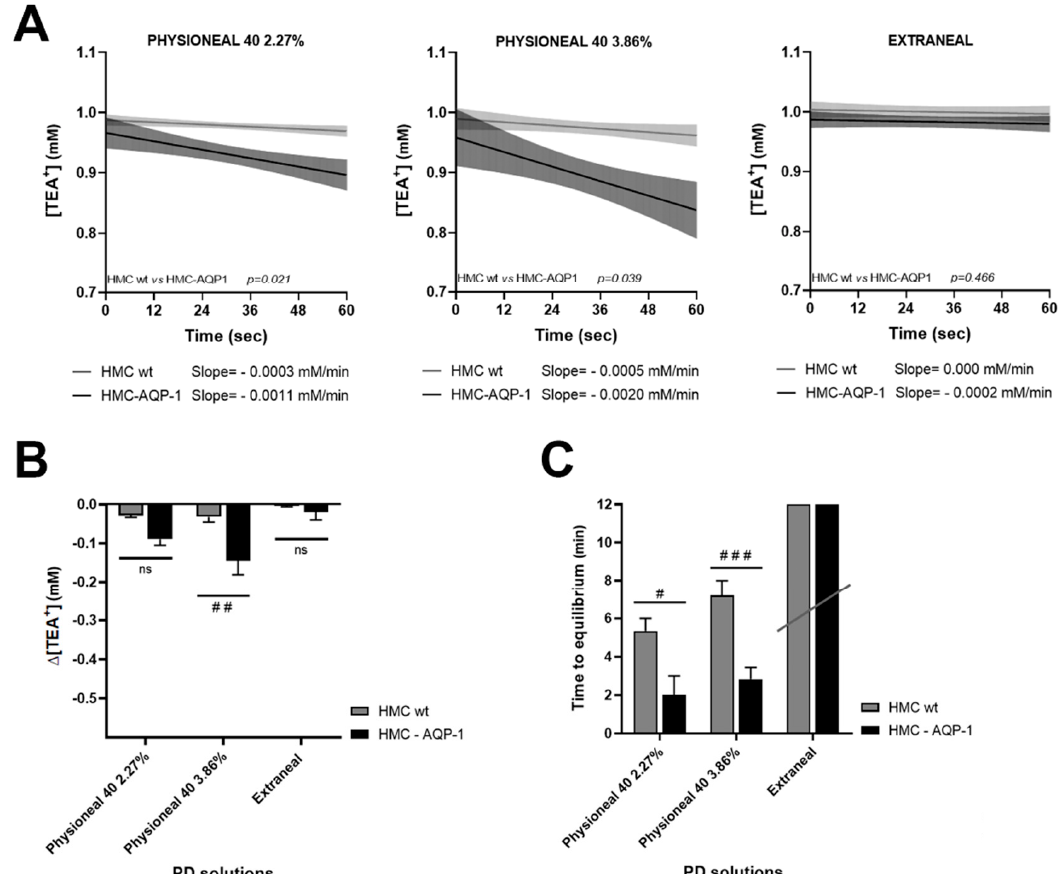
Figure 4. Osmotically induced transepithelial water transport in wt and AQP1-transfected HMC monolayers in response to Physioneal 40 2.27%, Physioneal 40 3.86% and Extraneal. ( A ) Slopes (solid lines) and 95% confidence interval (shaded areas, CI) for the regression of [TEA + ] calculated during the first 60 s of the response. Statistical analysis of the differences between slopes is reported within each panel. The value of the slopes is reported on the bottom of each panel; ( B ) Changes of [TEA + ] ( ∆ [TEA + ]) measured 1 min after application of PD solutions in the apical bath; ( C ) Histogram representing the time required to reach maximal TEA + dilution following PD solutions addition. Data are reported as mean values ± SEM. # p < 0.05; ## p < 0.01; ### p < 0.001; vs. HMC wt calculated by two-way analysis of variance (ANOVA) with Sidak’s multiple